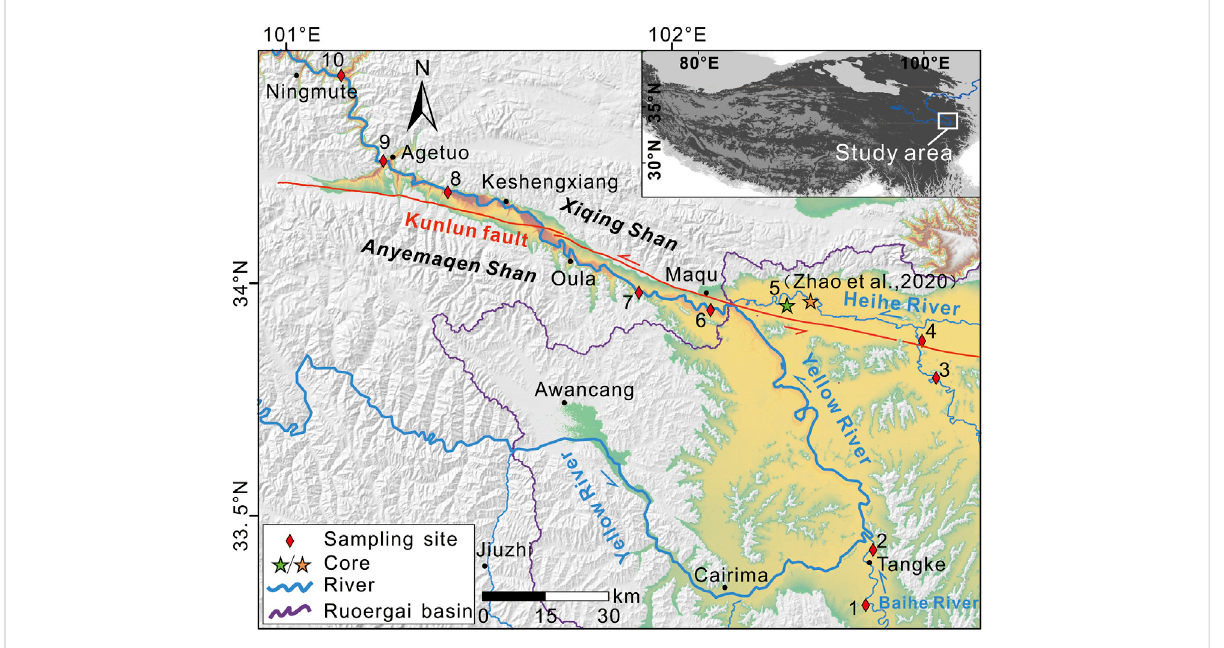
FIGURE 1 ThestudyareaandthesourceoftheYellowRivershowninGoogleEarthandDEMimages.Numbers1 – 10denotethesamplingsites.Thegreen star represents the core sampling site of this study, and the orange star represents the core sampling site of Zhao et al. (2020).